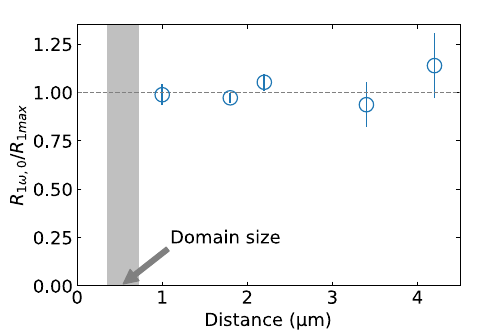
the Pt wires. For each of these cases, the upper (lower) panel shows the fi rst (sec- ond) harmonic nonlocal resistance. We plot the second-harmonic curves only for ϕ =90° because the second-harmonic signals for ϕ =0° through the fi lm to the detector where remain near zero in all